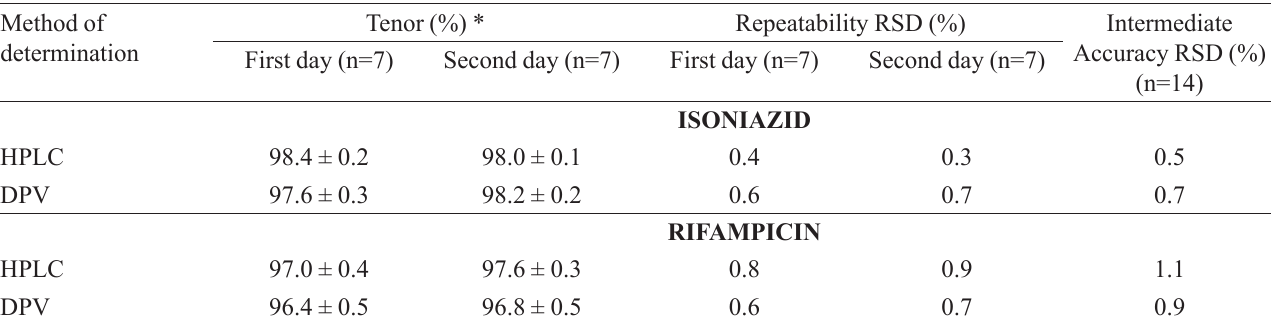
TABLE II – Comparison of ‘high performance liquid chromatography’ and ‘differential pulse voltammetry’ methods for determination of both, isoniazid and rifampicin, associated into a pharmaceutical formulation Method of